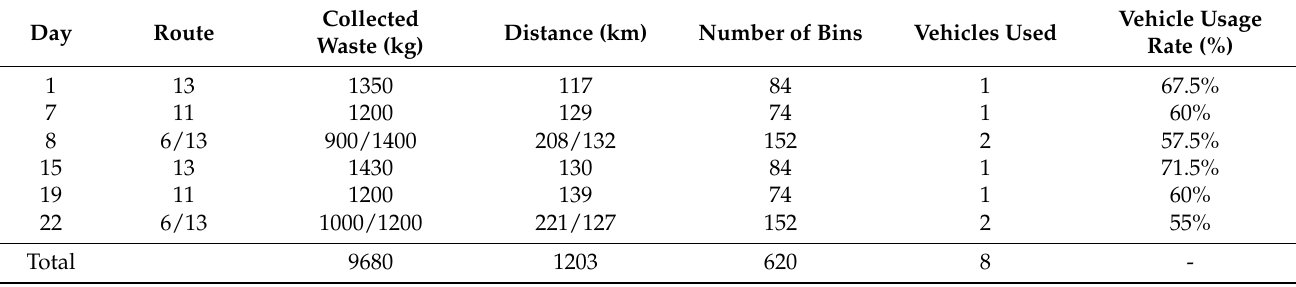
Table 8. Actual Valorsul operations